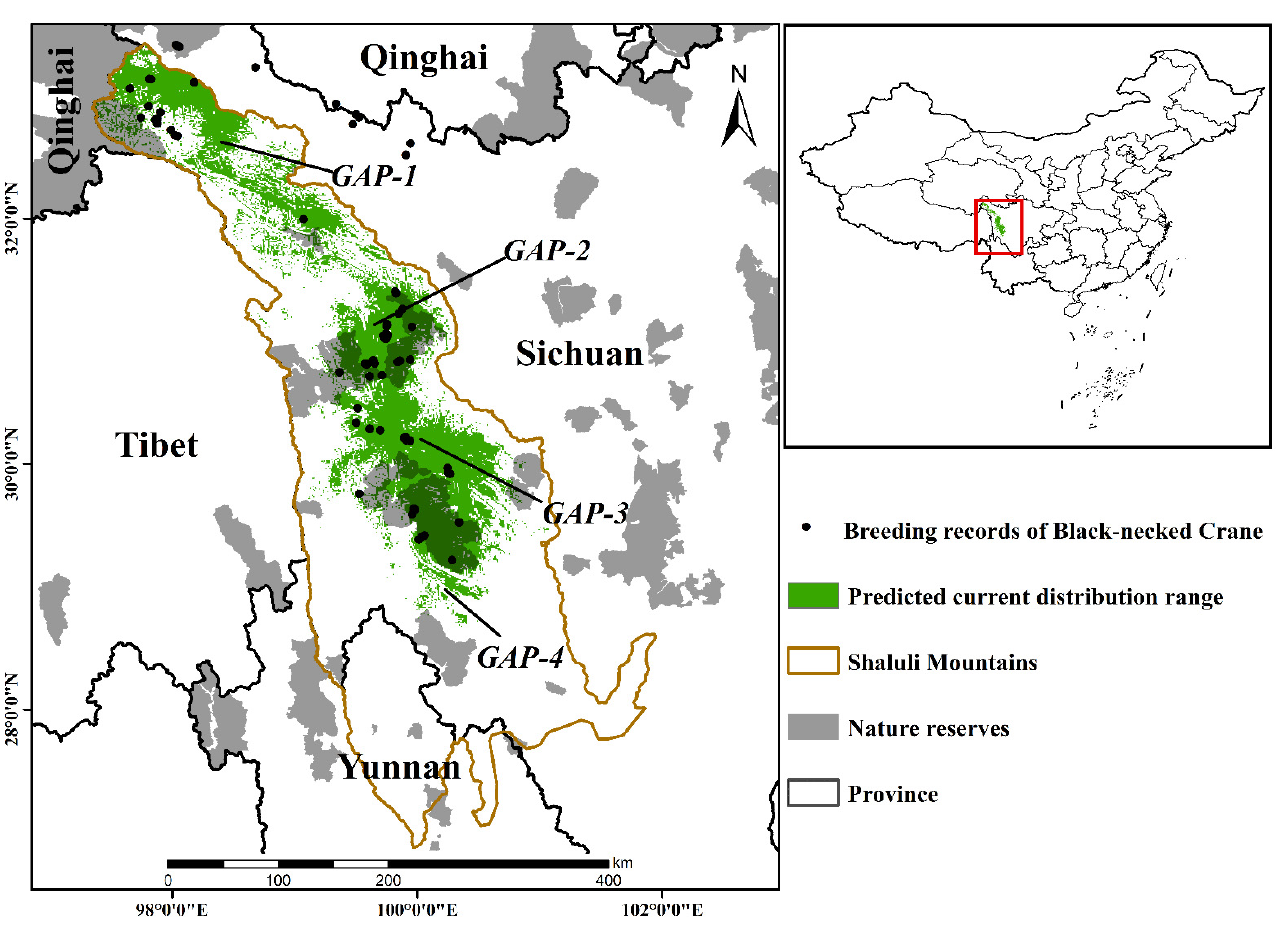
Figure 1. The predicted current distribution range of the black-necked crane and the conservation gaps (GAP-1,2,3,4) under the current nature reserves network in the Shaluli Mountains.